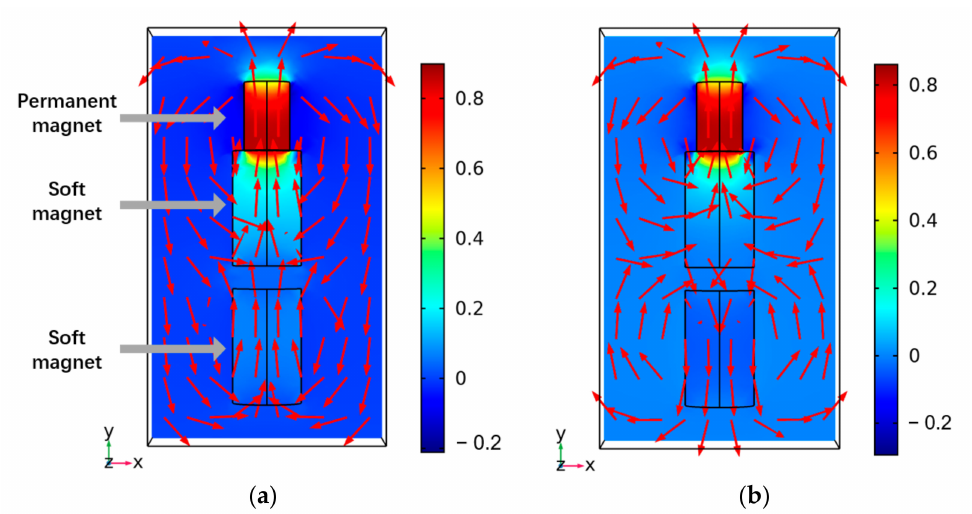
Figure 6. Simulation results looking at the assembly and separation of capsules. ( a ) The direction of the external magnetic field is the same as that of the permanent magnet. ( b ) The direction of the external magnetic field is opposite to that of the permanent magnet.